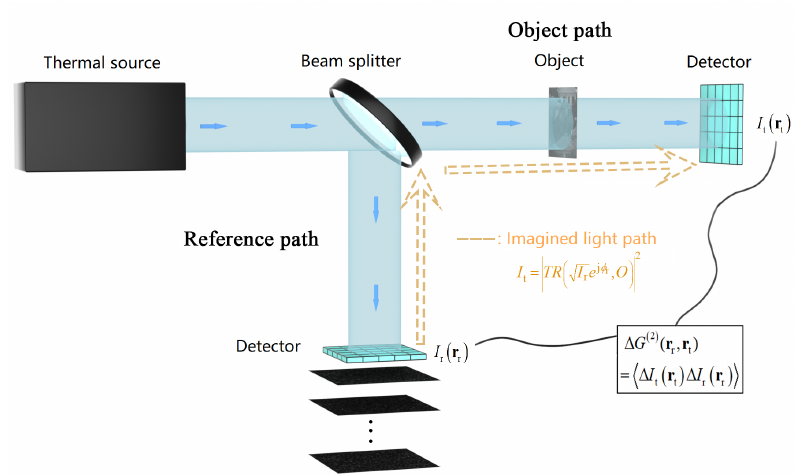
Figure 1. Diagram of ghost imaging. Light with spatiotemporal fluctuations is split into two beams (shown as the blue beams), one of which passes through the object (called the object path) and then is recorded by a detector as I t ( r t ) while the other propagates without passing through the unknown object (called the reference path) and is detected by another detector as I r ( r r ) . The point- to-point image information reproduction can be achieved by the second-order intensity correlation between the two detection signals. The orange arrows with dashed line shows the imagined path such that lights illuminating the object are emitted from the detection plane on the reference